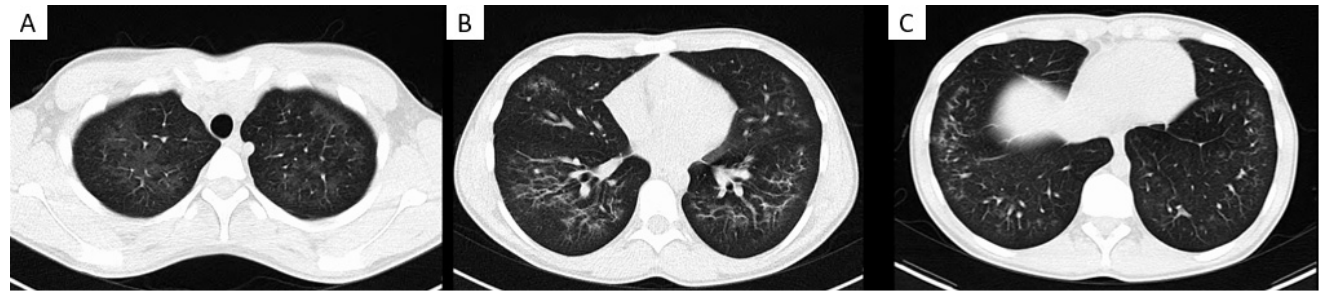
Figure 2. Images show electronic cigarette or vaping product use–associated lung injury in an 18- year-old male who attended our institution. Axial CT chest imaging ( A – C ) demonstrates extensive bilateral centrilobular and peri-bronchial ground glass opacification with subpleural sparing, slightly more confluent in the lower zones.